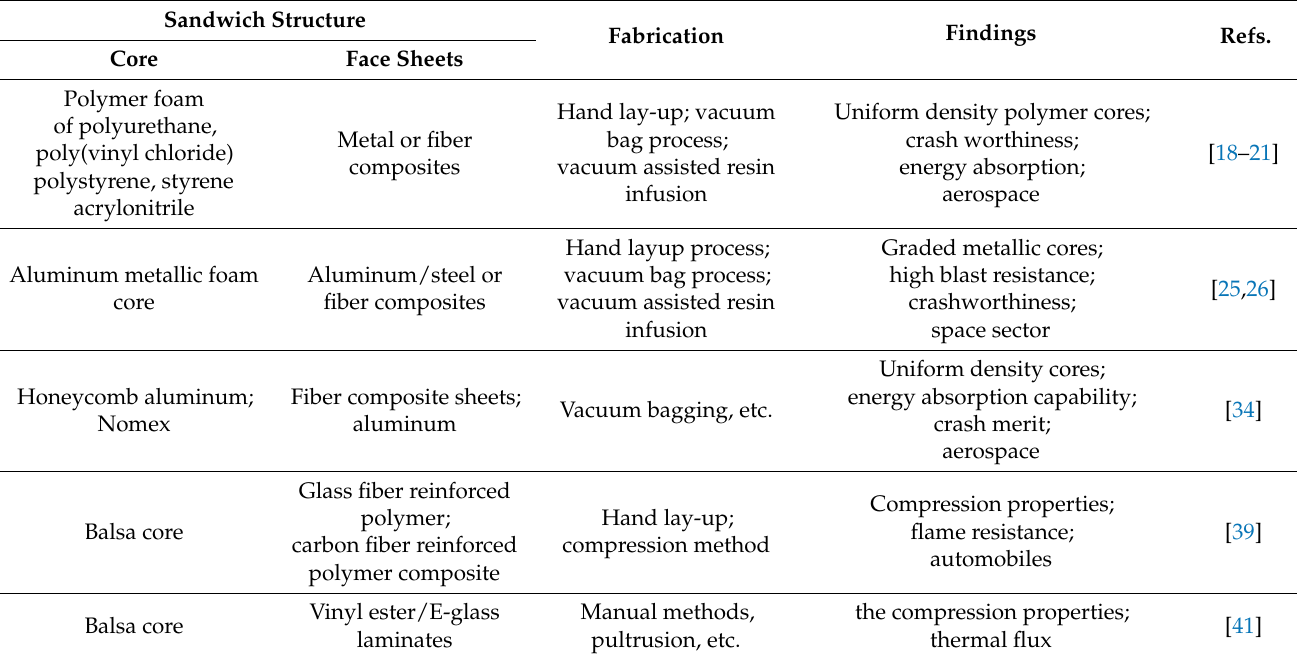
Table 2. Specifications of sandwich composite